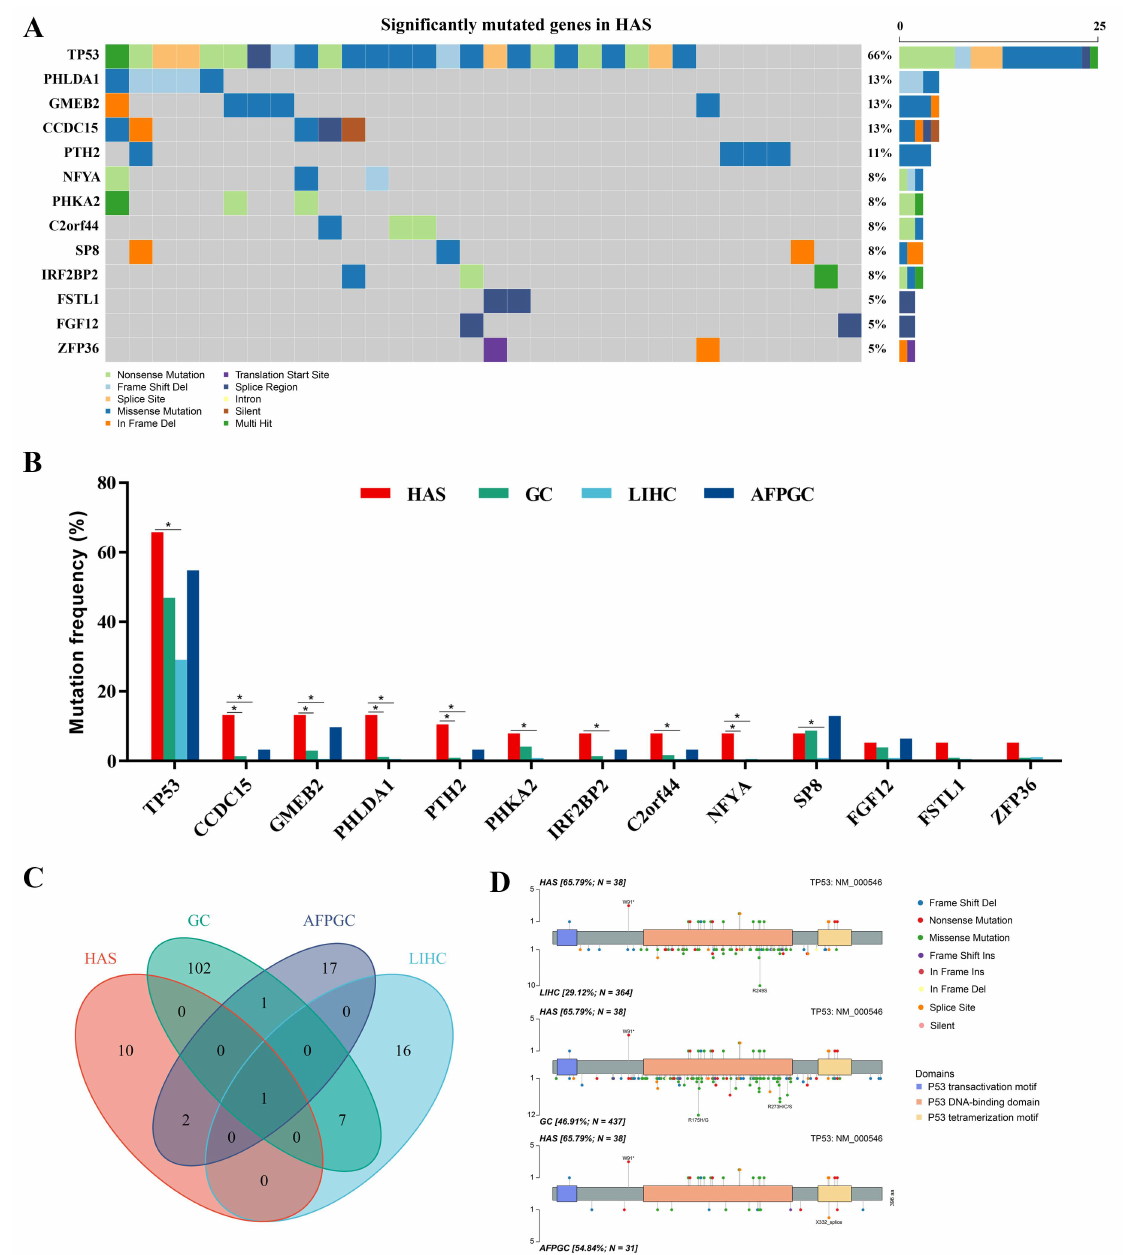
Figure 1. Mutational landscape of hepatoid adenocarcinoma of the stomach (HAS). ( A ) The signif- icantly mutated genes (SMGs) in 38 HAS patients. Different variant types are highlighted in different colors. p < 0.001 is statistically significant. ( B ) Comparison of frequencies of SMGs in HAS with liver hepatocellular carcinoma (LIHC), gastric cancer (GC), and AFP-producing GC (AFPGC). * p < 0.0167, statistically significant. ( C ) Intersection of all SMGs in these cancers. ( D ) Somatic mutation site distributions of TP53